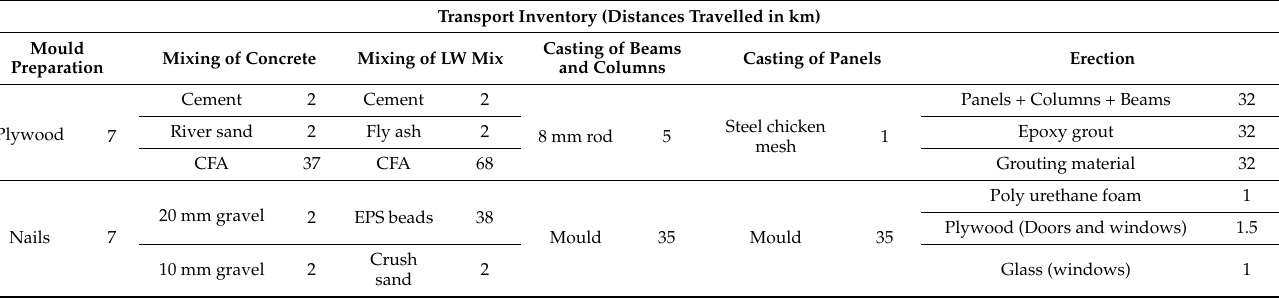
Table 10. Transport inventory distance travelled by raw materials and